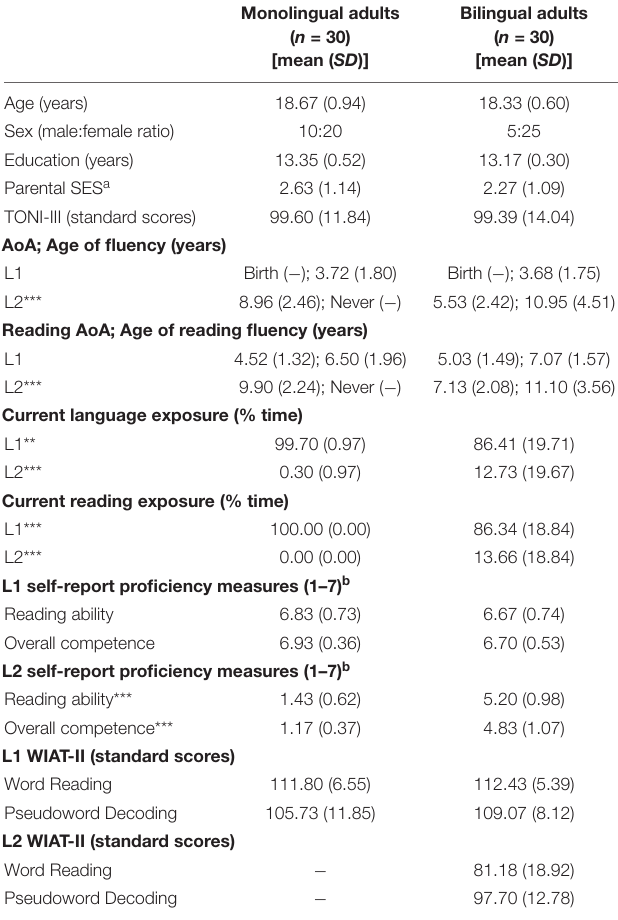
TABLE 2 | Characteristics of the adult participant